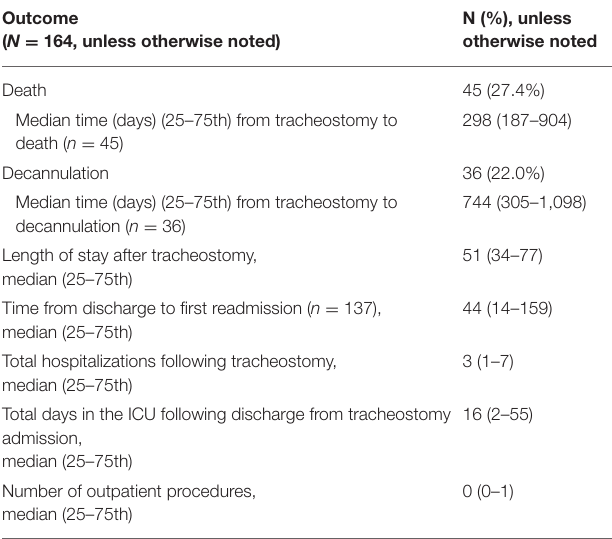
TABLE 3 | Outcomes and hospital